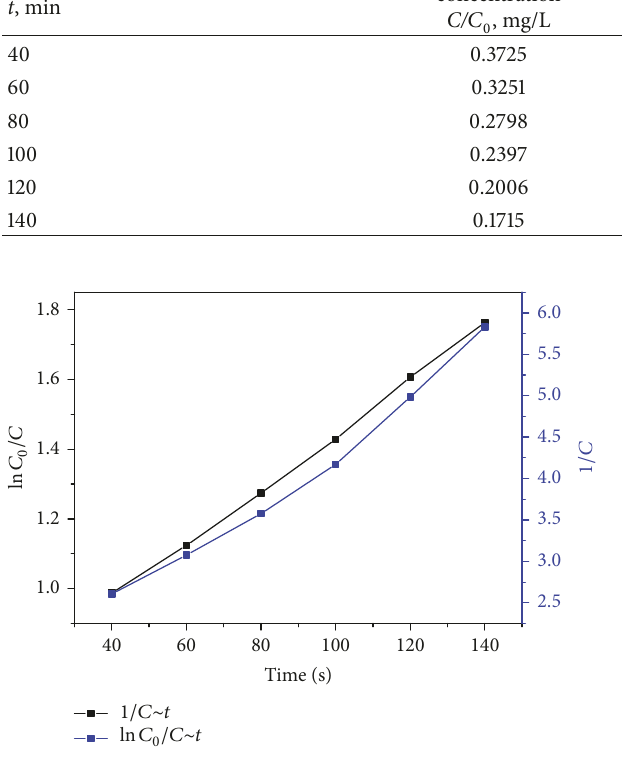
Figure 11: The kinetics analysis of Sr 0.7 K 0.3 TiO 3−𝛿 @PC-polyHIPEs for photocatalytic decomposition MB under visible irradiation.